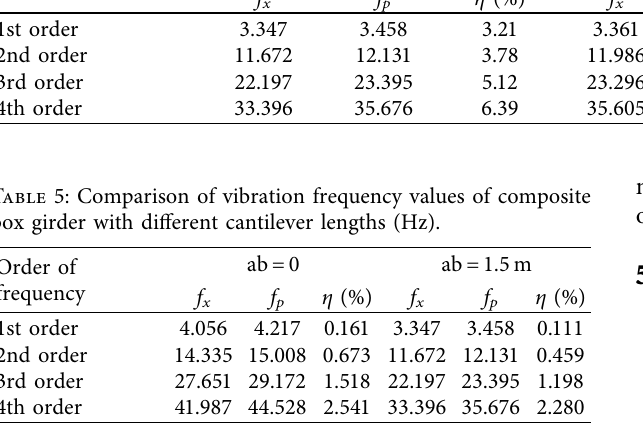
Table 4: Comparison of vibration frequency values of composite box girder with different corrugated web thicknesses (Hz). Order of frequency